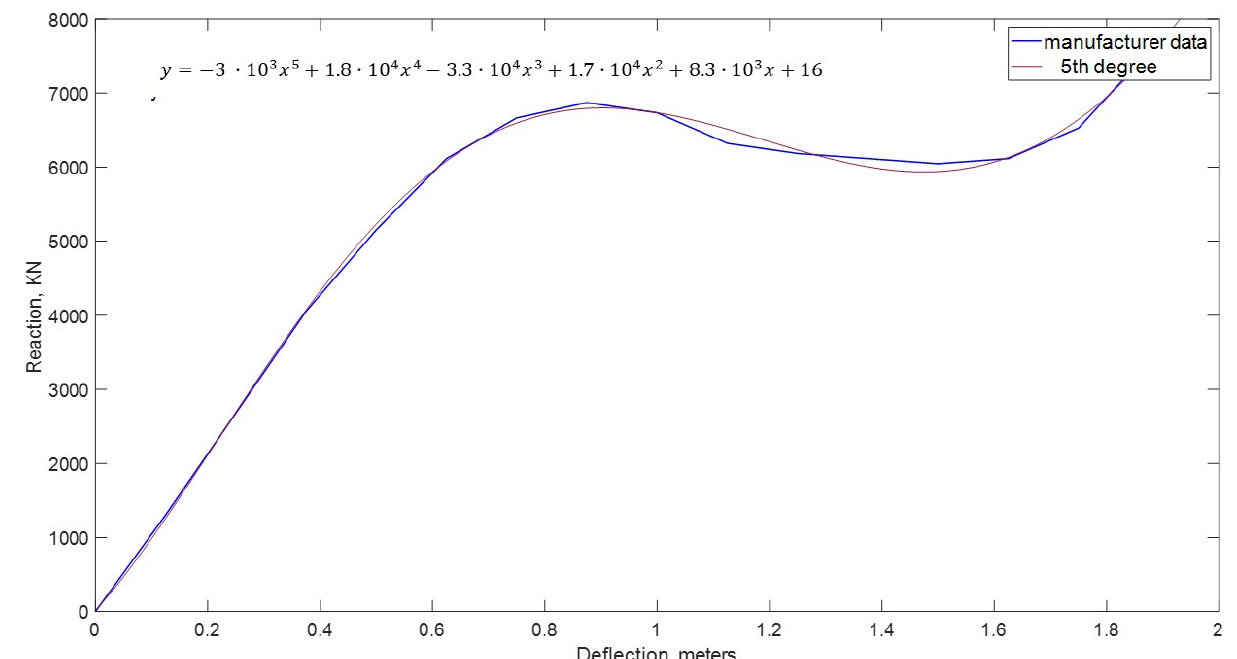
Stiffness: see Figure 6 for stiffness curve and its polynomial representation.